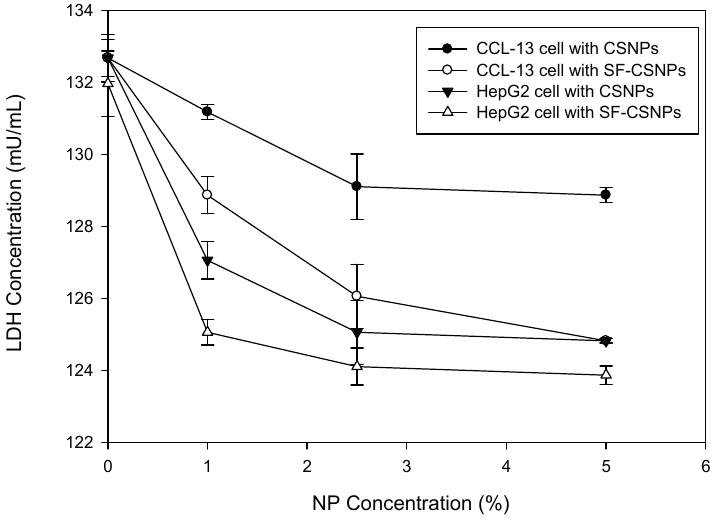
Figure 2. Lactate dehydrogenase (LDH) test of SF-CSNP and CSNP effects on CCL-13 and HepG2 cells ( n = 6, mean ± standard error, t -test, p < 0.05).